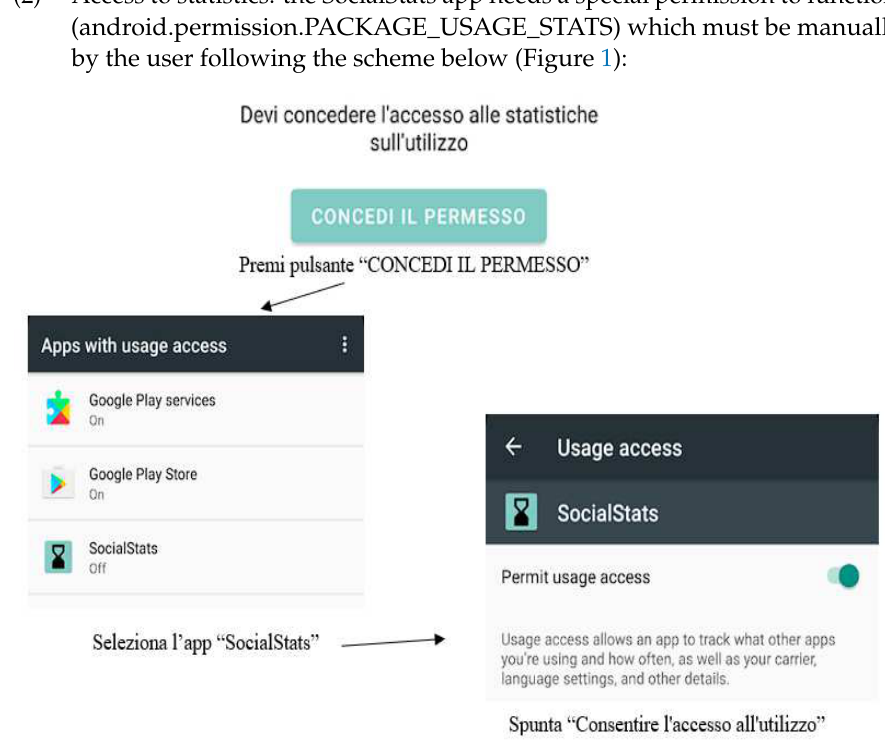
Figure 1. Permission phase of the app.